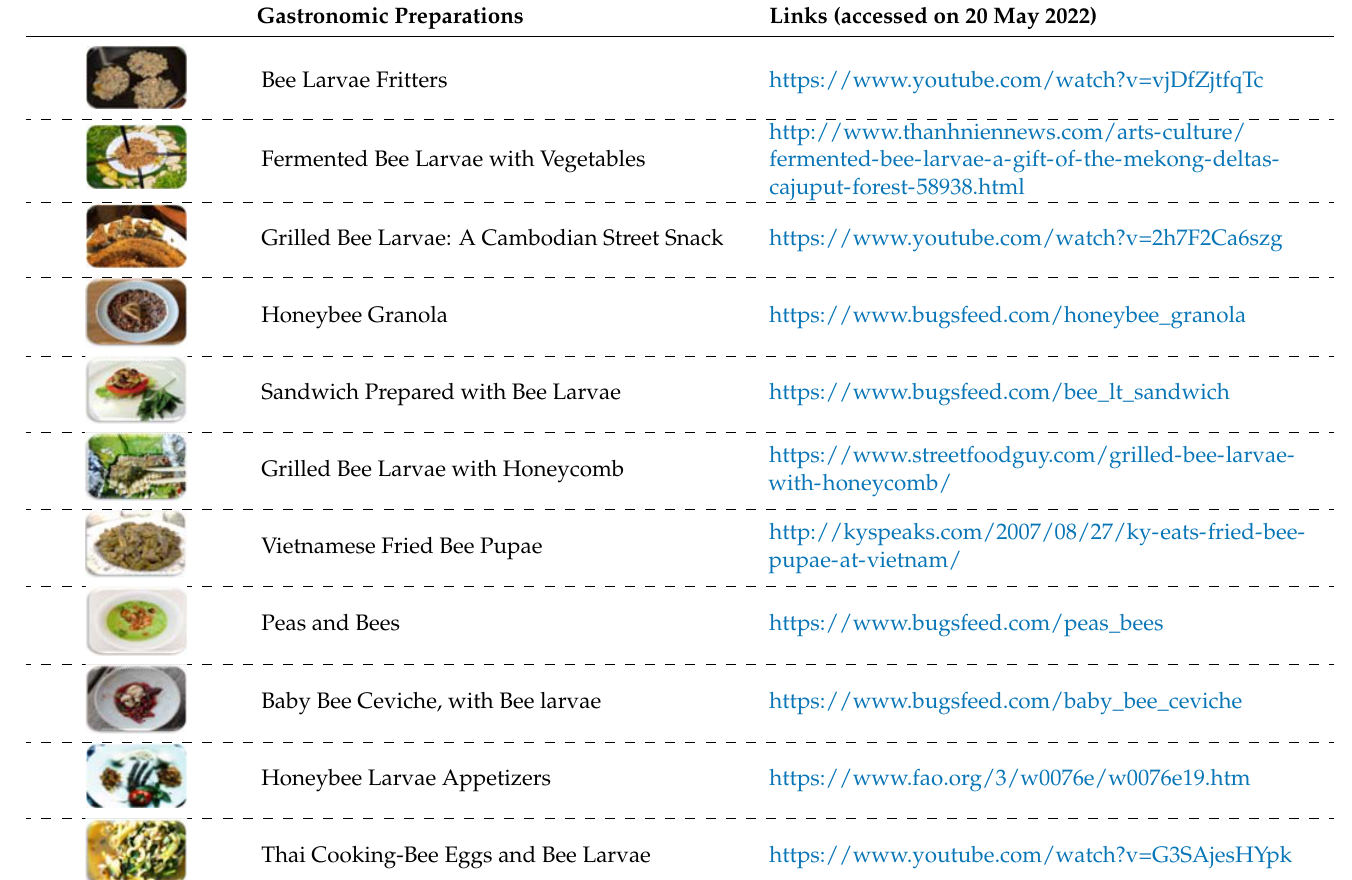
Table 8. Gastronomic preparations which include Apis mellifera brood.